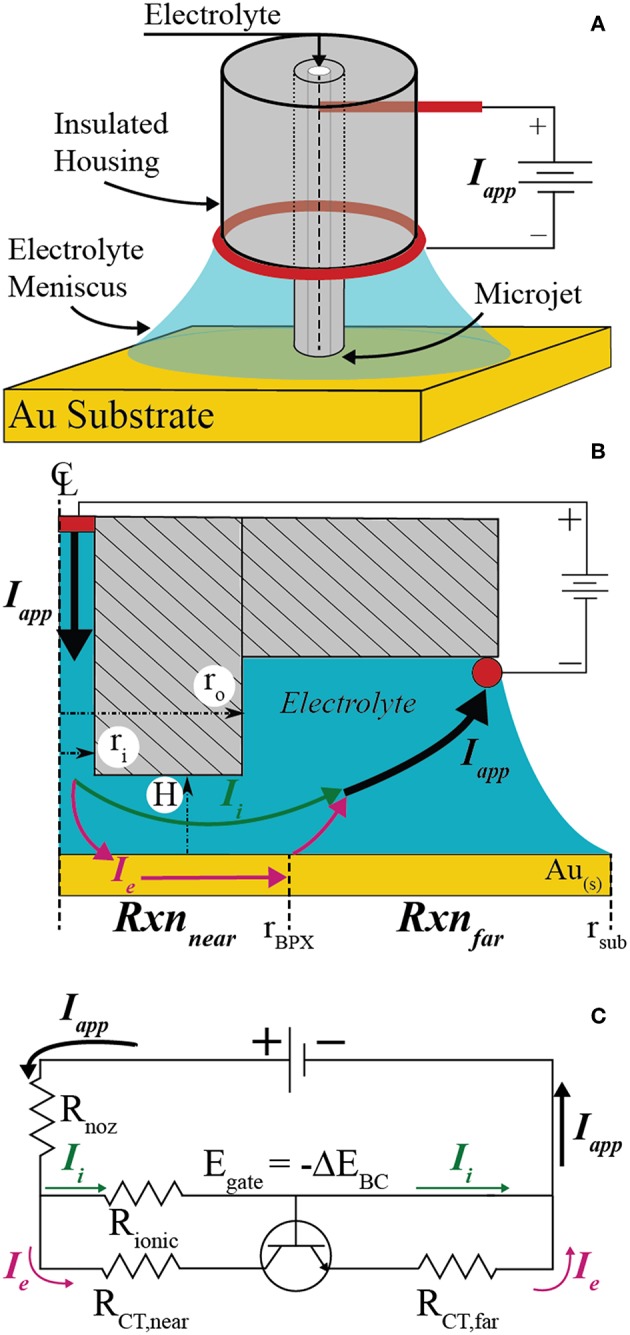
(A) Schematic of the scanning bipolar cell (SBC) and components. (B) To-scale axisymmetric geometry used in finite element method simulations when H = 2ri with key features and current pathways emphasized. (C) Equivalent circuit approximating current flow pathways through the SBC.